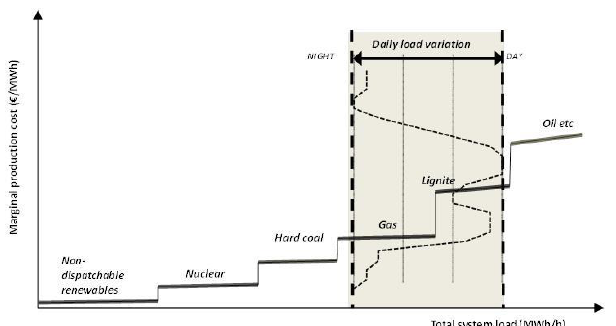
Fig. 4. Combination of marginal cost curve and curve with system load for a country/region.